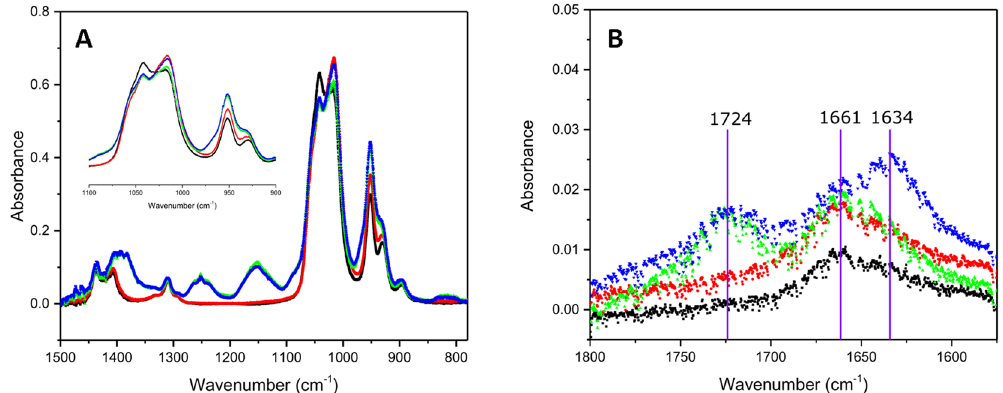
Figure 2. FTIR-ATR data of (NH 4 ) 2 MoS 4 solutions as seen in A and B . Black represents the solvent DMSO, Red represents 240 mg of